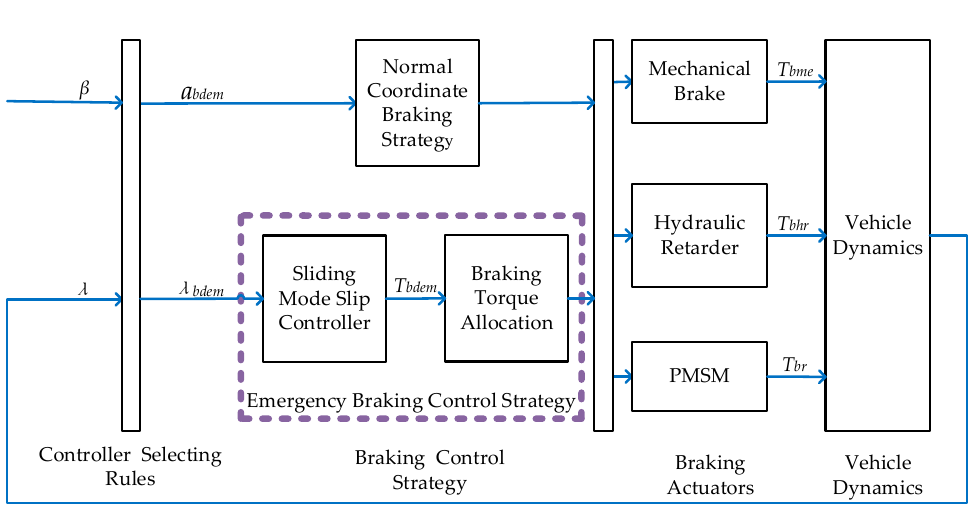
Figure 4. Schematic diagram of the braking system.